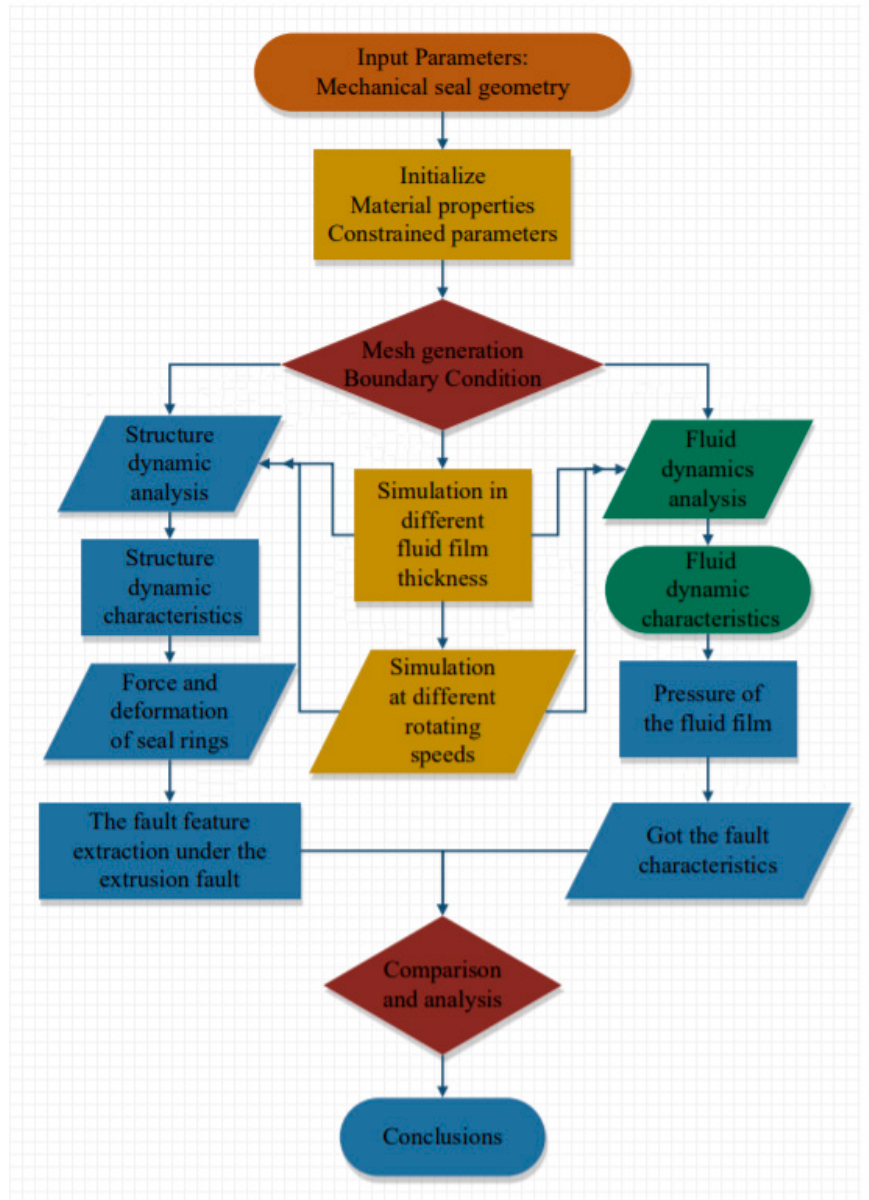
Figure 12. Flow chart of calculation.